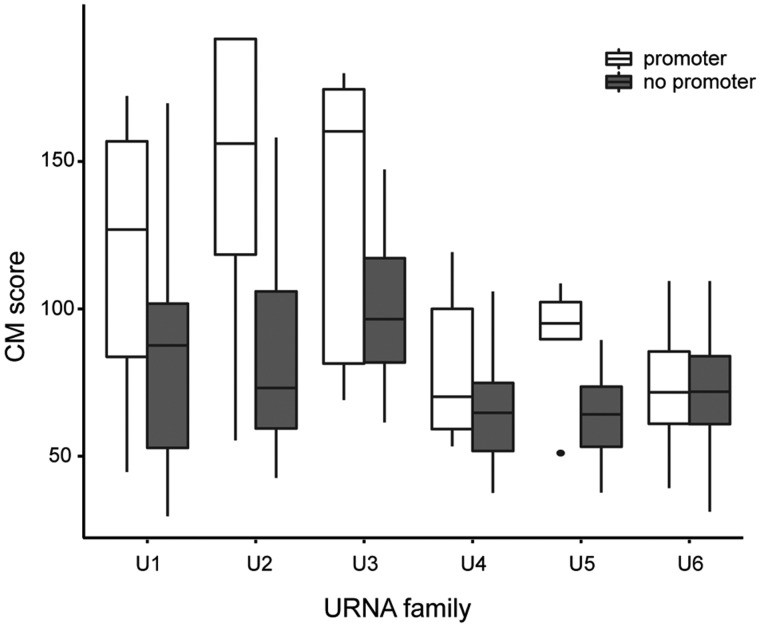
Rfam (release 12.1) CM scores for human U1–U6 loci (EnsEMBL version 83) with and without predicted upstream pol-II promoter. A comparison of annotation scores (higher = better) for six families of frequently duplicated small RNAs shows good correlation with promoter presence as indicator for function in U1, U2, U3, and U5 (Kolmogorov–Smirnov, P < 0.05) and no clear correlation for snRNAs U4 and U6 (Kolmogorov–Smirrnov, P > 0.5), the latter of which is known to not be transcribed by pol-II but pol-III. This finding suggests that promoter presence can be an important factor in identifying functional from nonfunctional (and thereby likely decaying) copies.